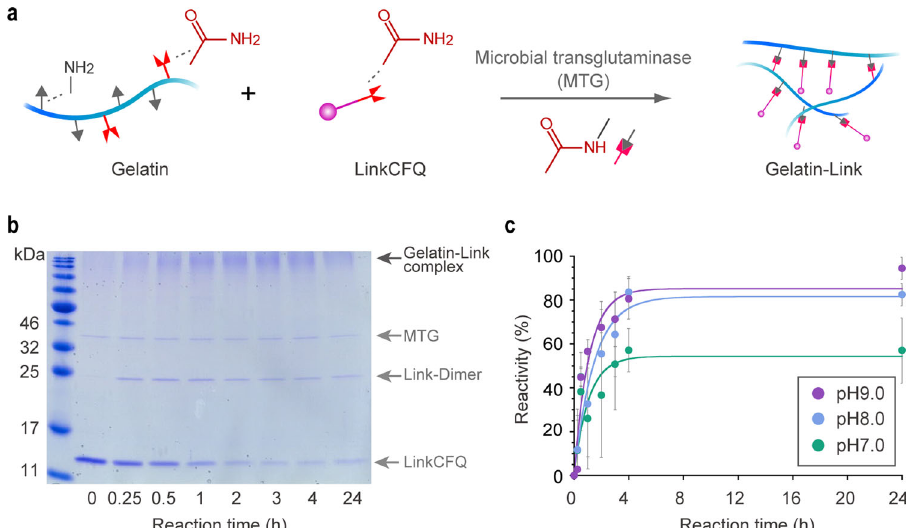
Fig. 4 MTG-catalyzed conjugation reaction between LinkCFQ and gelatin. a Puri fi ed LinkCFQ was crosslinked with fi sh gelatin at different pH values (pH 7, 8, and 9) at 4 °C for 0 – 24 h. b Representative images of sodium dodecyl sulfate – polyacrylamide gel electrophoresis analysis of the reaction mixture at pH 8.0. Other images, at pH 7 – 9, are presented in Supplementary Fig. 6. c Reactivity (%) was de fi ned and calculated using Eq. 3. The time course of experimental enzyme-catalyzed reactivity (%) was fi tted using Eq. 4 64 . Glutamine and lysine residues are illustrated using red and gray graphics, respectively. All error bars represent standard deviations.